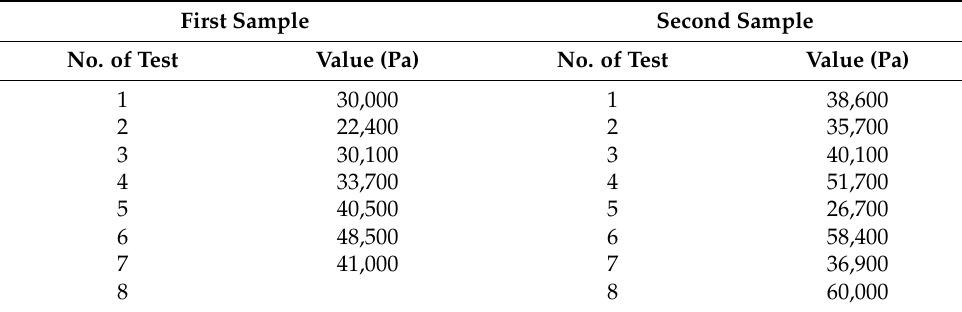
Table 1. The ultimate strength of the